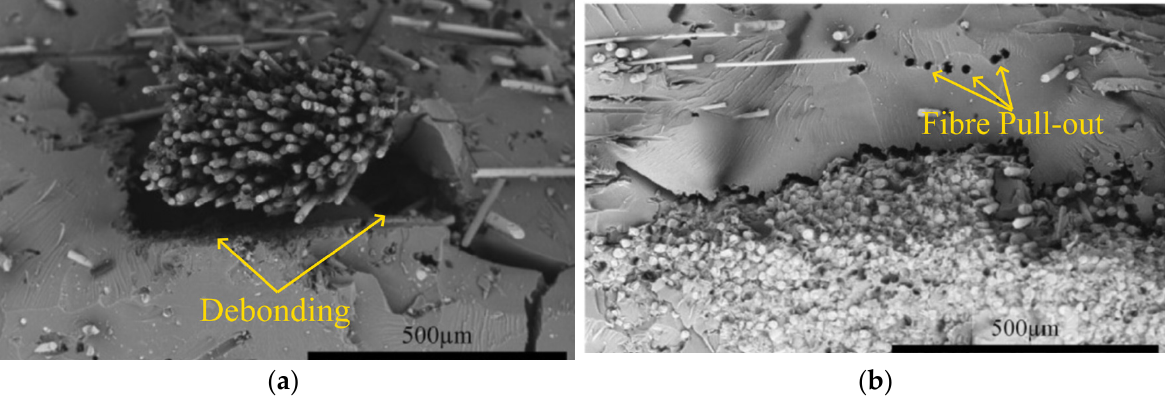
Figure 14. SEM image of the tensile fracture surface of rGF-reinforced polyester resin composite: debonding phenomenon ( a ); fibre pull-out ( b ) [103].